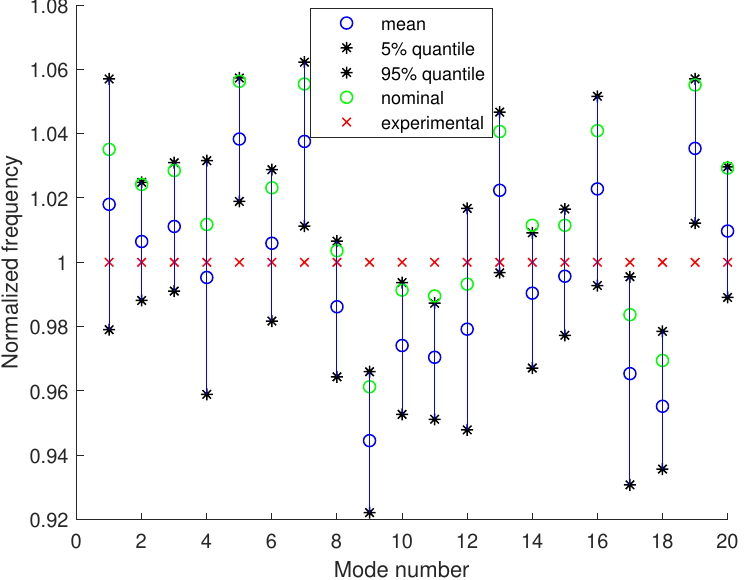
Figure 6. Uncertainty propagation to the first 20 modal frequencies compared with the experimental data and nominal